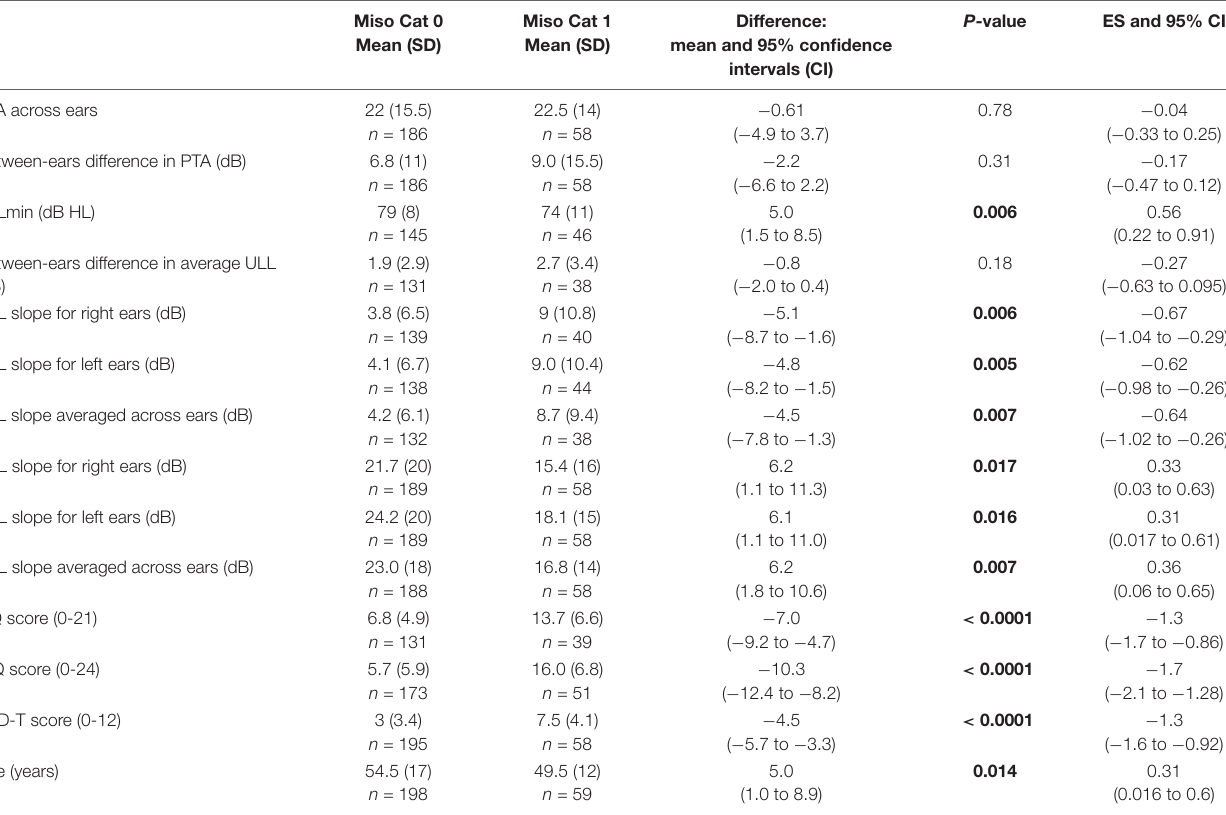
TABLE 2 | Results of independent-samples Welch’s t -tests comparing the PTA (pure tone average) averaged across ears, between-ears difference in PTA, ULLmin (across-frequency average uncomfortable loudness level for the ear with lower average ULL), between-ears difference in average ULL, ULL slope (the value of the difference in ULLs between 8 and 1 kHz) for each ear and averaged across ears, HTL slope (absolute values of the differences in hearing threshold levels between 8 and 1 kHz) for each ear and averaged across ears, scores for the TIQ (Tinnitus Impact Questionnaire), HIQ (Hyperacusis Impact Questionnaire), SAD-T (Screening for Anxiety and Depression-Tinnitus), and age for groups Miso Cat 0 and Miso Cat 1. Significant p values are indicated in bold